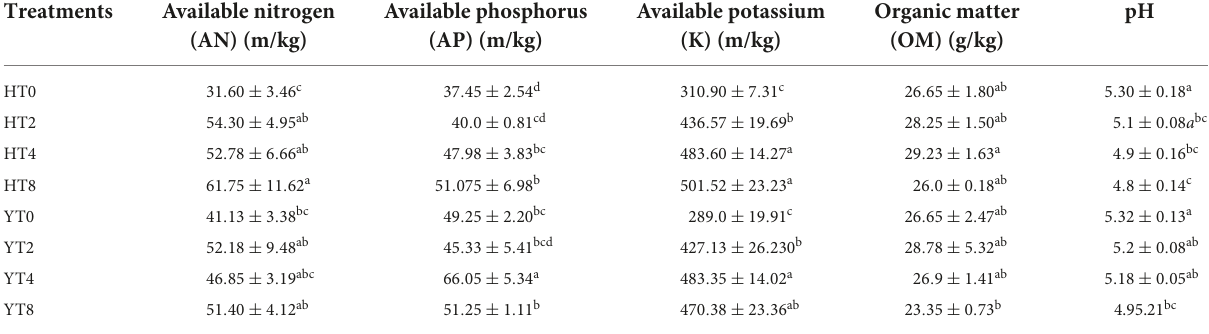
TABLE 1 Physicochemical properties (Mean ± SD) of both varieties Honghua Dajinyuan (H) and Yunyan 87 (Y). Treatments Available nitrogen